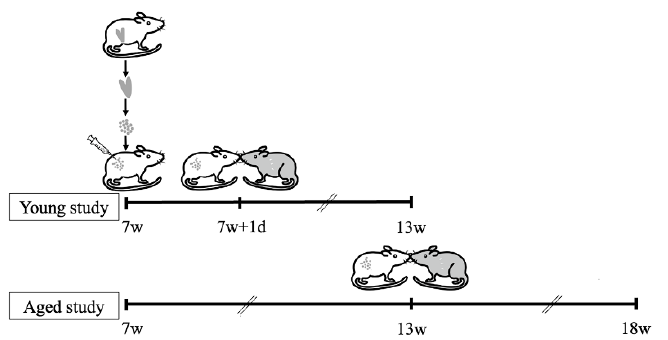
Figure 1. A schematic diagram showing the flow of the two studies (Young study and Aged study). This diagram shows experiment of the two studies (Young study and Aged study). Day 0 represents the day endometriosis was established. In the Young study, mating was initiated on day 1 and repeated every 4 days until day 42; in the Aged study, mating was initiated on day 43 and repeated every 4 days until day 84. To describe the experiments based on their week age, endome- triosis was established or sham-operated at 7 weeks of age, and the mice were mated for 6 weeks each, from 7 to 12 weeks of age in the Young study and from 13 to 18 weeks of age in the Aged